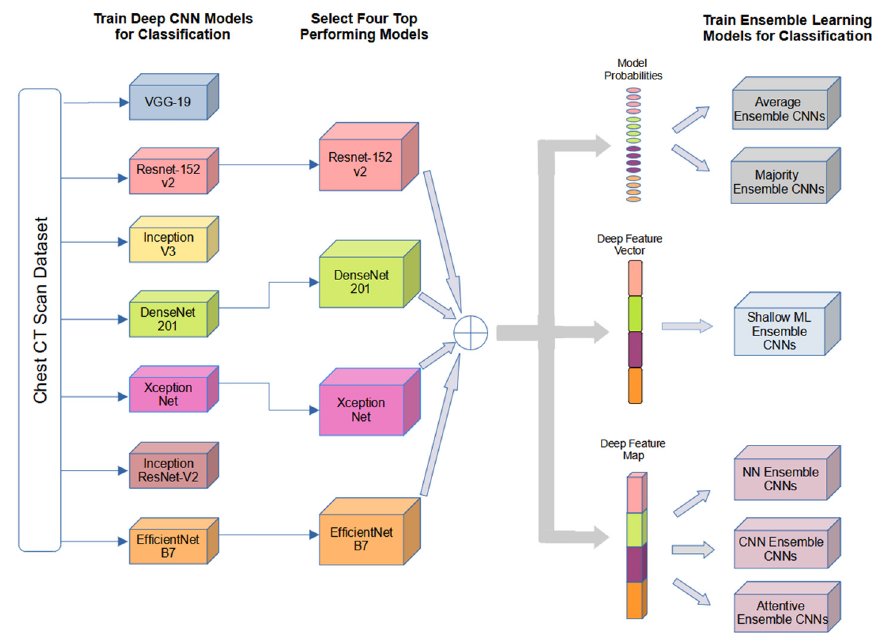
Figure 6. Overview of Methodology.